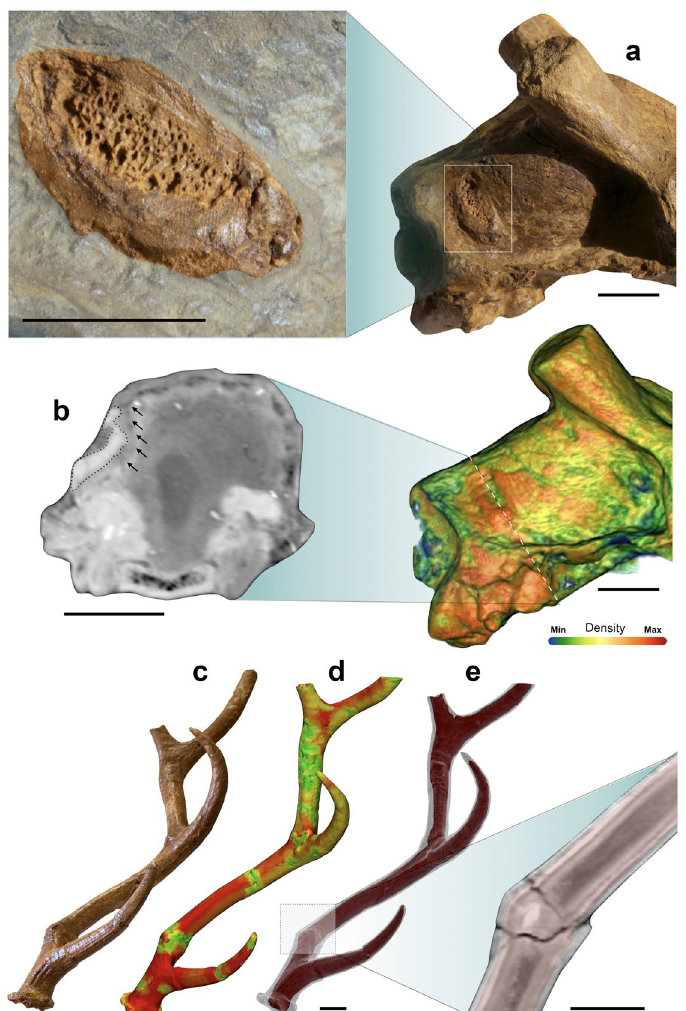
Figure 4. Palaeotraumatological evidence of the Pantalla specimens. ( a ) Traumatic injury with magnification of the bone callus on SABAP_UMB 337643. ( b ) Bone density filter applied on the same specimen with magnification of the cranial cross-section (dotted line) at the level of the lesion; black arrows indicate the depression on the left hemisphere. ( c–e ) Injured left antler of SABAP_UMB 337655 ( c ), with density filter ( d ) and magnification of the fracture and bone callus ( e ). Scale bars: 3